Question: Name the type of graph shown.
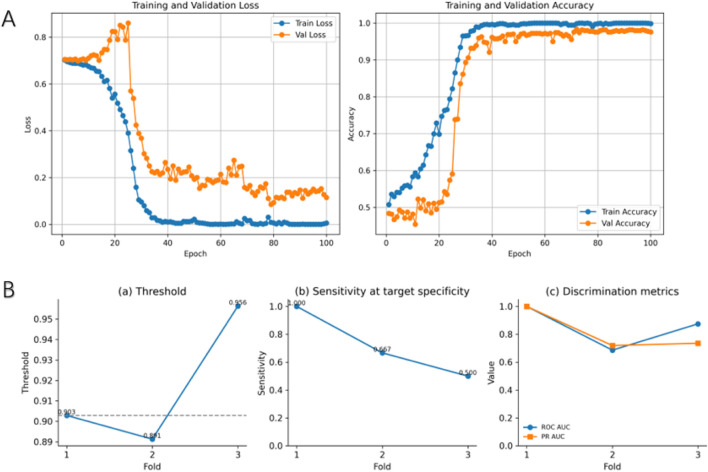
Answer: line